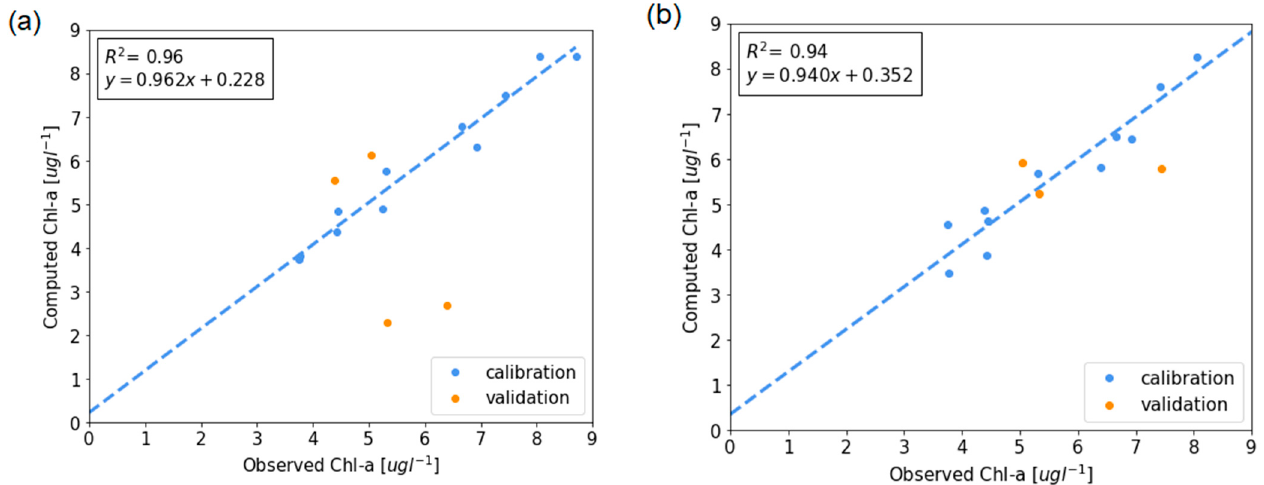
Figure 6. Computed vs. observed Chl-a concentrations for the fall-winter period: ( a ) Chl-a calculated using TOA data (L1C) and ( b ) Chl-a calculated using BOA data (L2A). Dashed lines correspond to the perfect agreement between computed and observed Chl-a concentrations.